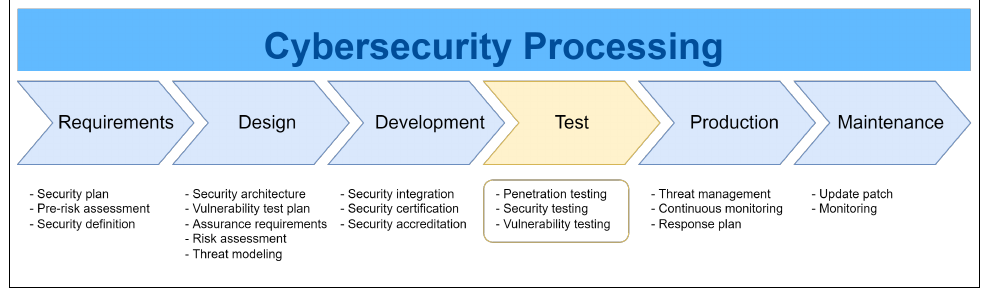
Figure 2. Cybersecurity processing during